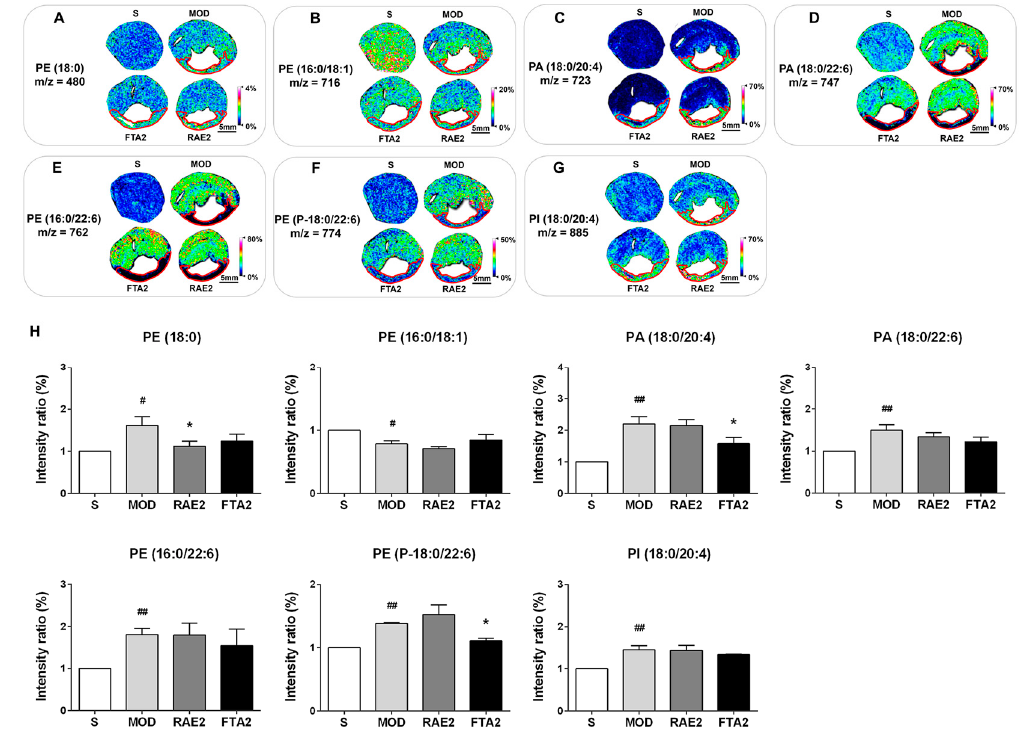
Figure 7. RAE and FTA decreased phospholipids. In situ MALDI–MSI of ( A ) phosphatidylethanolamine (PE) (18:0), ( B ) PE (16:0 / 18:1), ( C ) phosphatidic acid (PA) (18:0 / 20:4), ( D ) PE (18:0 / 22:6), ( E ) PE (16:0 / 22:6), ( F ) PA (P-18:0 / 22:6), and ( G ) phosphatidylinositol (PI) (18:0 / 20:4). ( H ) Relative intensity ratios of the seven phospholipids were normalized and analyzed using SCiLS Lab. Spatial resolution = 200 µ m; scale bar = 5 mm. m / z : mass-to-charge ratio. S, sham surgery group; MOD, MI model group; RAE2, 0.8 g / kg Radix Aconiti Lateralis Preparata extract group; FTA2, 0.8 g / kg fuzi total alkaloid group. Data are presented as mean ± standard error of the mean; n = 3 per group. # p < 0.05, ## p < 0.01 vs. S group, * p < 0.05 vs. MOD group.